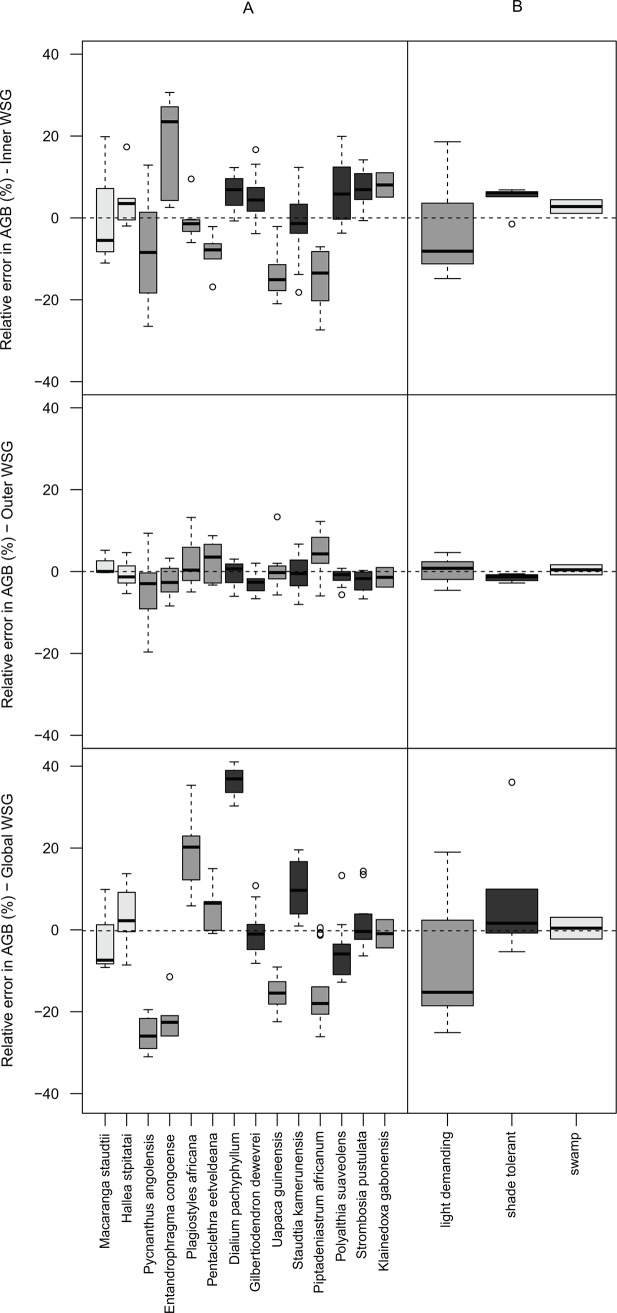
Boxplots of the relative errors calculated for the 14 species (A) and the three regeneration guilds (B) sampled in Malebo, the Democratic Republic of the Congo.Relative errors were calculated using weighted-WSG as reference and using the inner-WSG, the outer-WSG and the global-WSG as proxies. Swamp, light-demanding and shade-tolerant species are respectively colored in light grey, grey and dark grey, respectively.